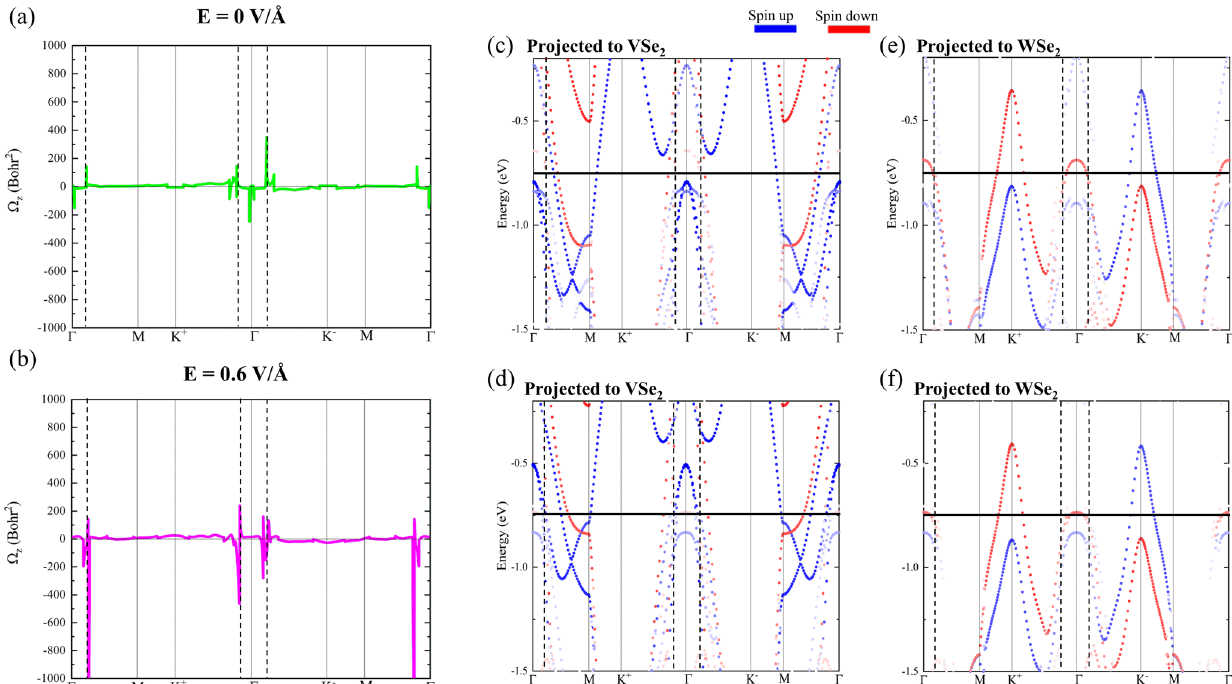
Fig. 5 Electric fi eld-dependent Berry curvature. Calculated Berry curvature ( Ω ) in the high symmetry directions at the chemical potential of − 0.75 eV of the WSe 2 /VSe 2 heterostructure for C-II stacking at a E = 0 and b 0.6 V Å − 1 . Projected SOC band structure to the VSe 2 layer at c E = 0 V Å − 1 and d E = 0.6 V Å − 1 , and projected SOC band structure of the WSe 2 layer at e E = 0 V Å − 1 and f E = 0.6 V Å − 1 . The solid line represents the chemical potential at − 0.75 eV. Blue and red lines represent the majority spin (spin-up) and minority spin (spin-down) band